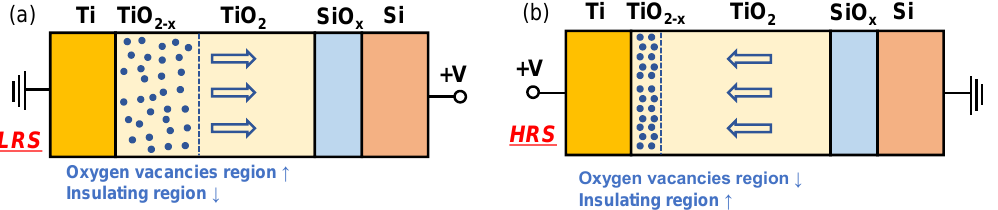
Figure 3. Illustration of a simple oxygen vacancy model to explain the conductance change of Ti / TiO 2 / SiO x / Si device in ( a ) low-resistance state (LRS) and ( b ) high-resistance state (HRS). Oxygen vacancies are full circles with blue color and the arrows indicate the moving direction of oxygen ions.